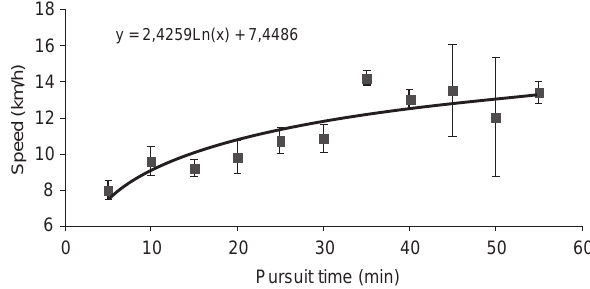
Figure 2. Mean speed and pursuit time, and respective tendency line and logarithmic equation registered in this study. A positive correlation was seen between the two measures in the initial min- utes, and the mean speed stabilized after 30 min of pursuit.